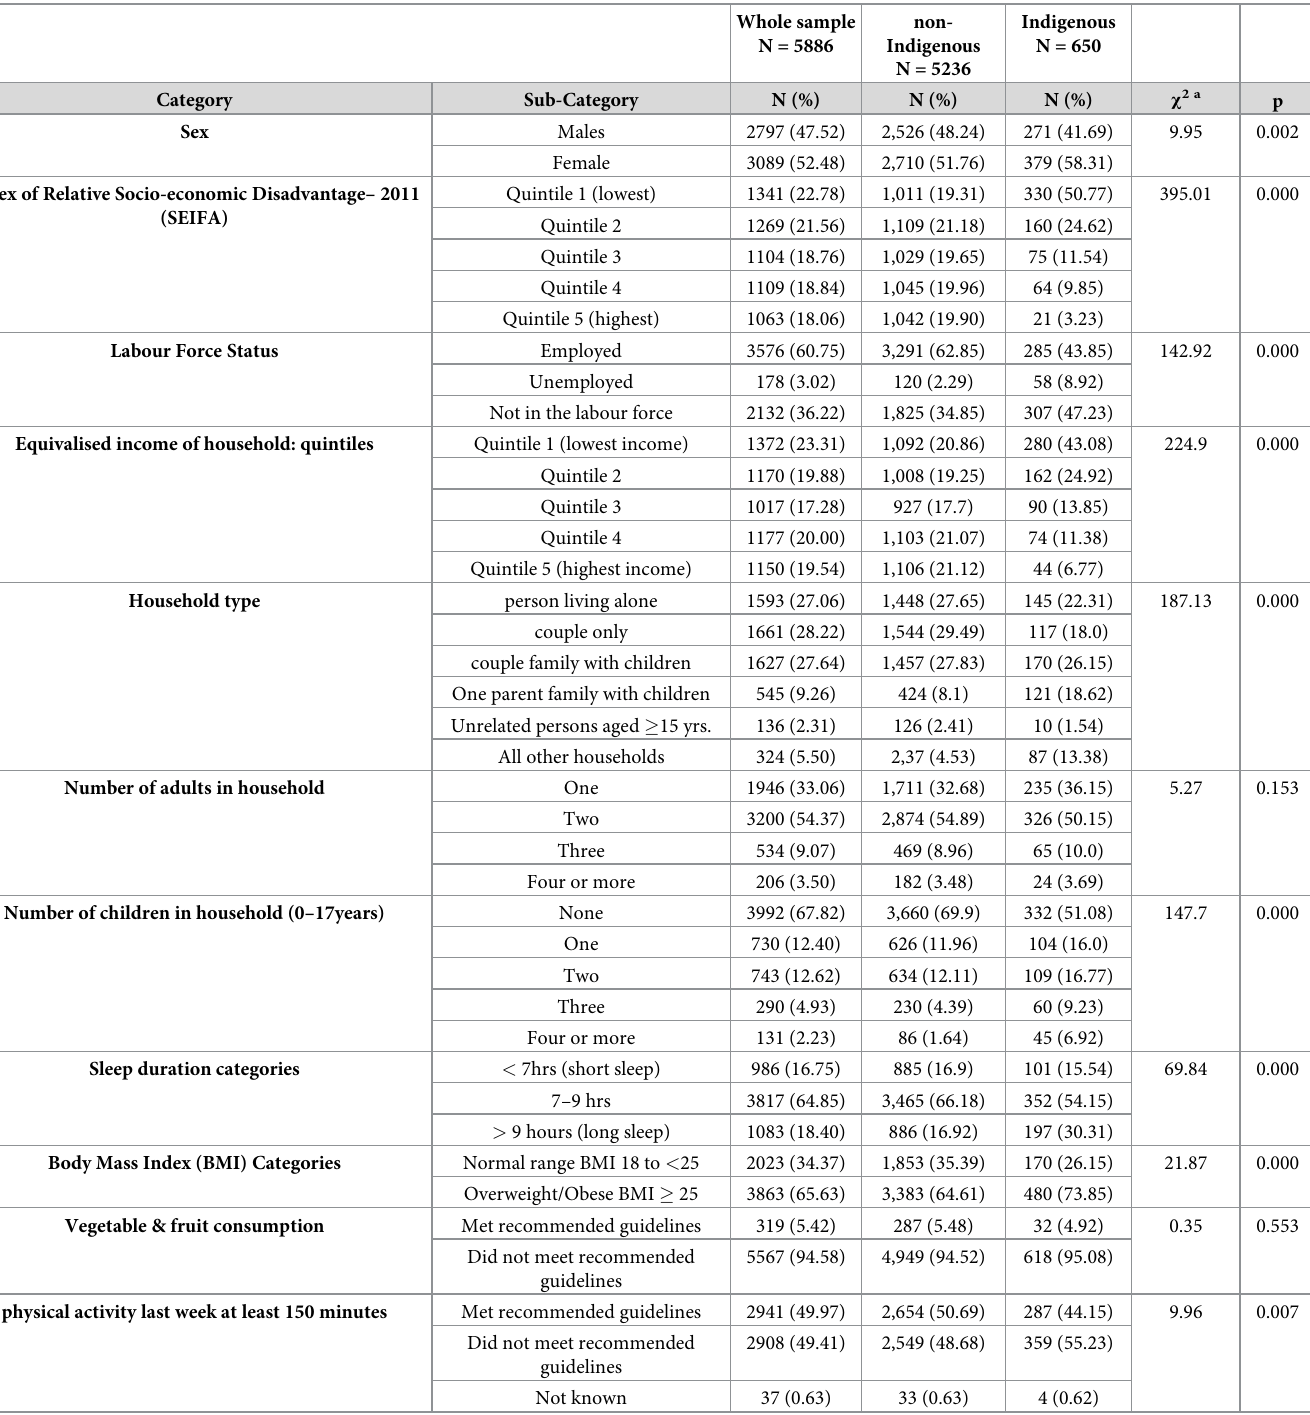
Table 1. Demographic data describing whole sample and Indigenous and non-Indigenous